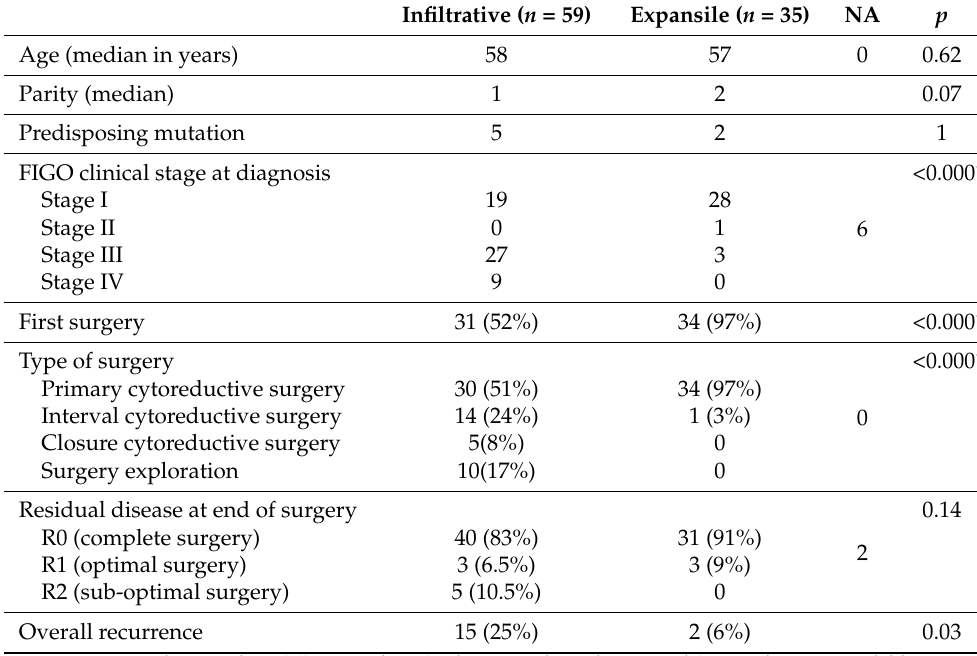
Table 2. Characteristics of the population according to the type of mucinous tumour ( n =